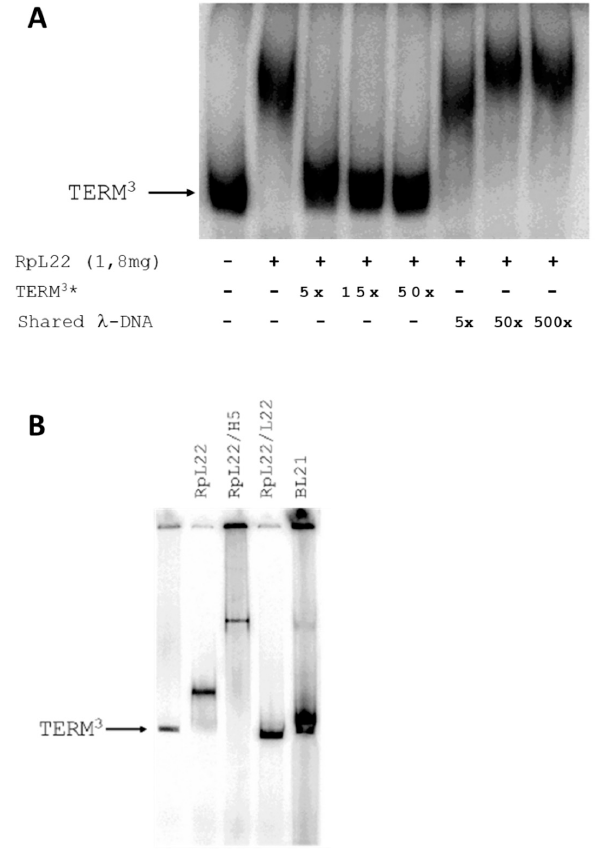
Figure 3. Rpl22 binds the TERM 3 in vitro. Each lane contains an identical amount of input labeled TERM 3 DNA (2 ng) incubated with recombinant purified Rpl22 protein. ( A ) TERM3-Rpl22 complex formation has shown in the lane 2, whereas the remaining lanes are committed to specific and not-specific competition experiments: specific competitor (unlabeled TERM 3 *) or a large excess of non-specific competitor (shared λ -DNA) were used as shown in figure; ( B ) identification of which domain of RpL22 is responsible for binding with TERM 3 : we used purified Rpl22 (1.8 µ g), RpL22/H5 (1.2 µ g), and RpL22/L22 (0.6 µ g). We used different amounts of the proteins to maintain the same stoichiometric ratio. The experiment suggests that only the RpL22/H5 polypeptide is able to bind TERM 3